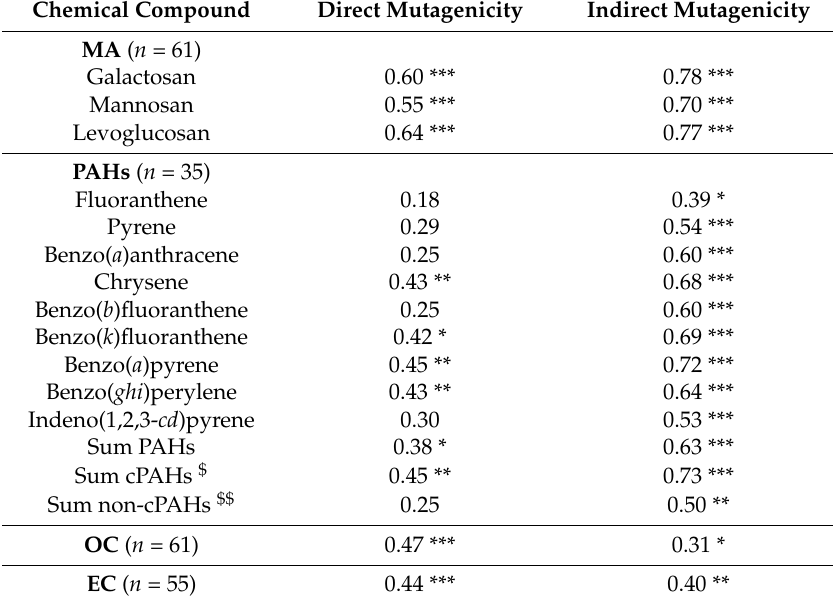
Table 3. Spearman rank correlation coefficients ( r s ) between chemical characteristics of PM 10 and both direct and indirect mutagenicity (variables expressed on mass base (per 100 µg PM 10 -equivalent). Significant correlations are indicated (* p < 0.05; ** p < 0.01; *** p < 0.001).